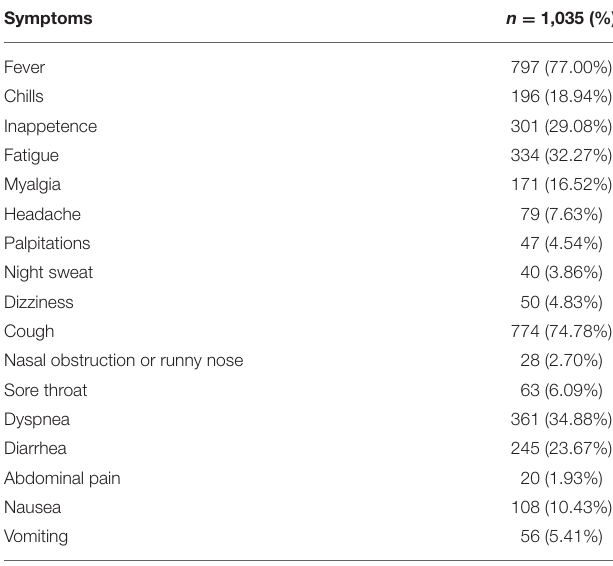
TABLE 3 | Frequencies of symptoms before admission of 1,035 COVID-19 patients.